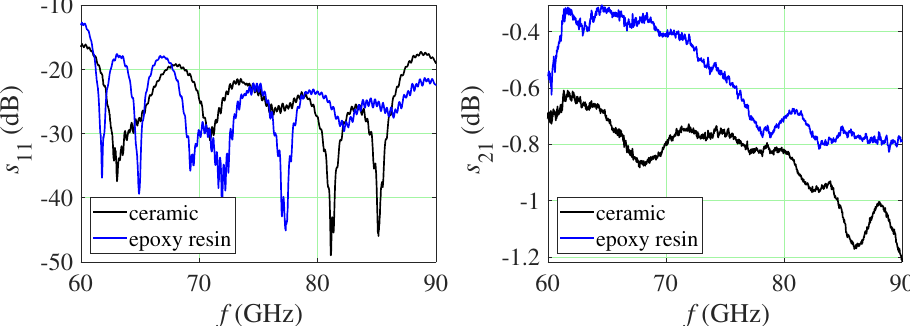
Figure 9. Measured return loss s 11 and insertion loss s 21 of the fabricated WR12